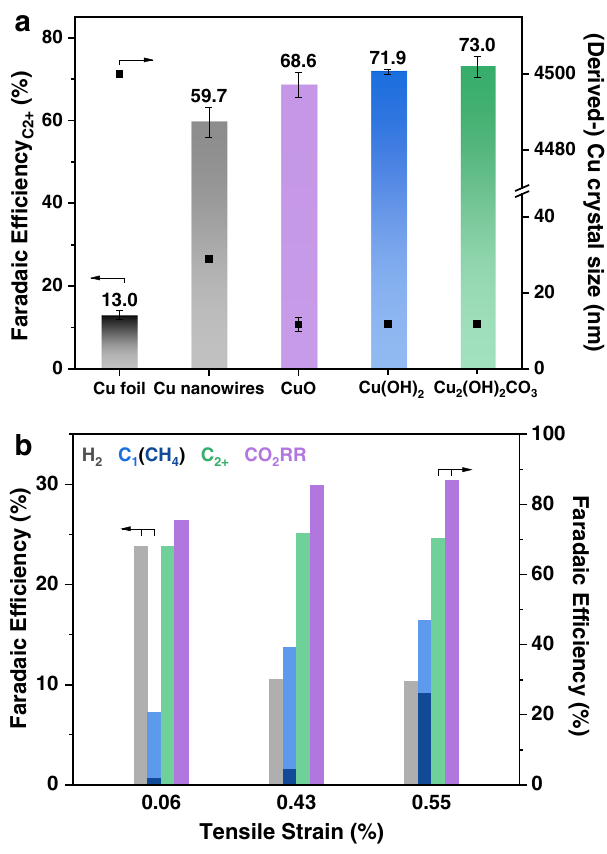
Fig. 5 | Size and strain effects on CO 2 RR behaviors of Cu-based catalysts. a Maximum Faradaic ef fi ciencies for C 2+ products and the crystal sizes of the derived Cu (from Cu 2 (OH) 2 CO 3 , Cu(OH) 2 , and CuO nanocrystals), Cu nanowires, andpolycrystallineCufoil. b DifferenttensilestrainvaluesofthederivedCu(along the [111] direction) and the corresponding Faradaic ef fi ciencies for H 2 , C 1 , CH 4 , C 2+ products, and the overall CO 2 RR at ~ − 1.1V RHE . Samples with 0.06%, 0.43%, and 0.55% tensile strains represent the Cu derived from CuO, Cu(OH) 2 , and Cu 2 (OH) 2 CO 3 , respectively. Error bars represent the standard deviation of three independent